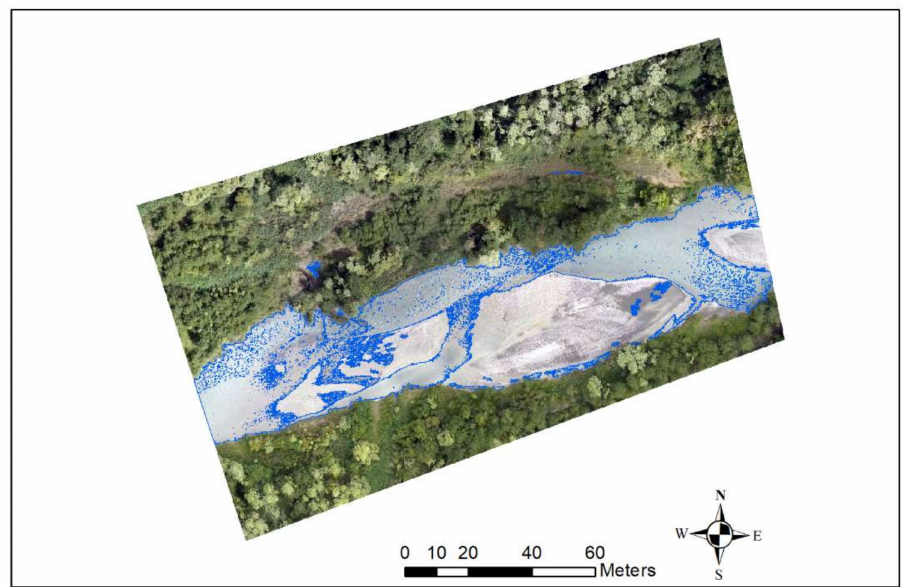
Figure 8. Example of polygonised water contour on third classified cloud (areas > 1 sqm).